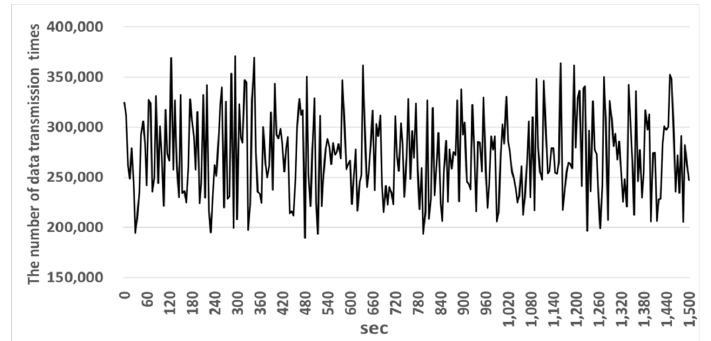
Figure 13. Data transmission quantity in the existing gateway. Appl. Sci. 2018 , 8 , x FOR PEER REVIEW